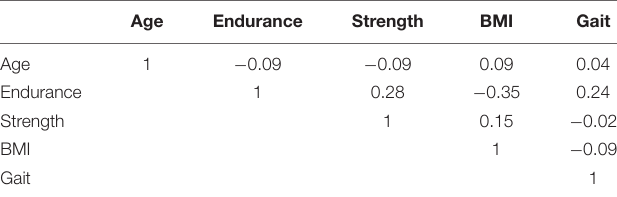
TABLE 2 | Correlations among physical fitness measures and age.